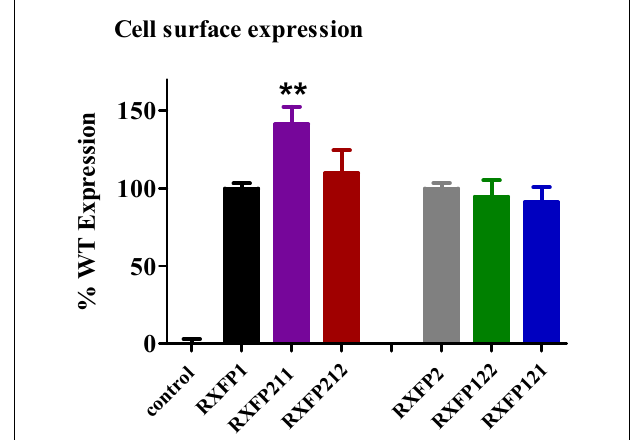
FIGURE 3 | Cell surface expression of chimeric receptors compared to the RXFP1 and RXFP2 wild-type (WT) receptors . Data are expressed as mean ± SEM of triplicate determinations from at least three independent experiments. ** p < 0.01 compared to